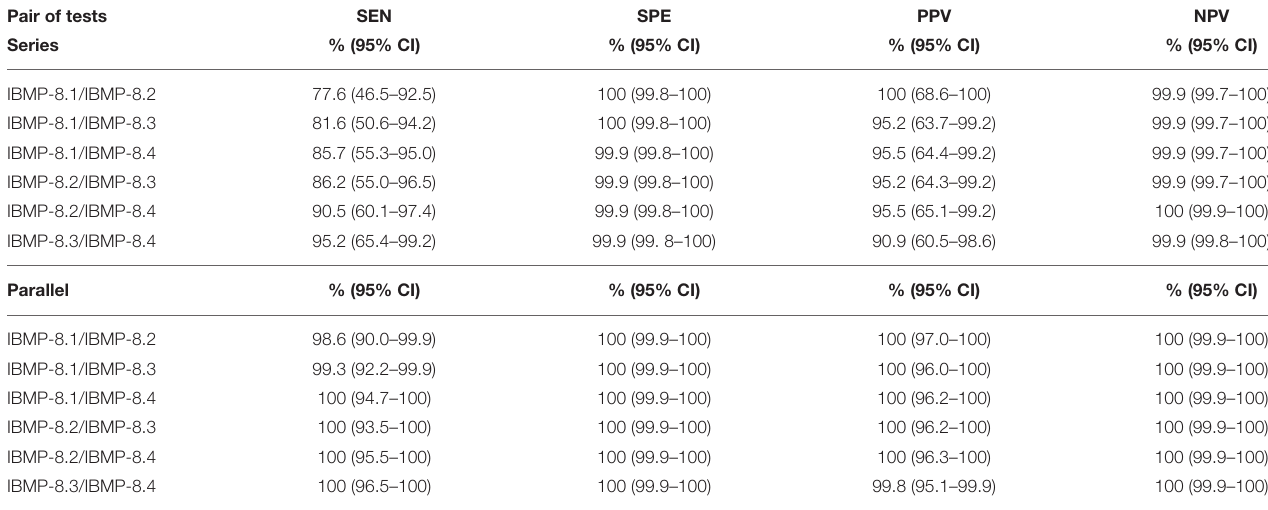
TABLE 3 | Analysis of the diagnostic performance of the pair of chimeric IBMP proteins using serial and parallel approaches. Pair of